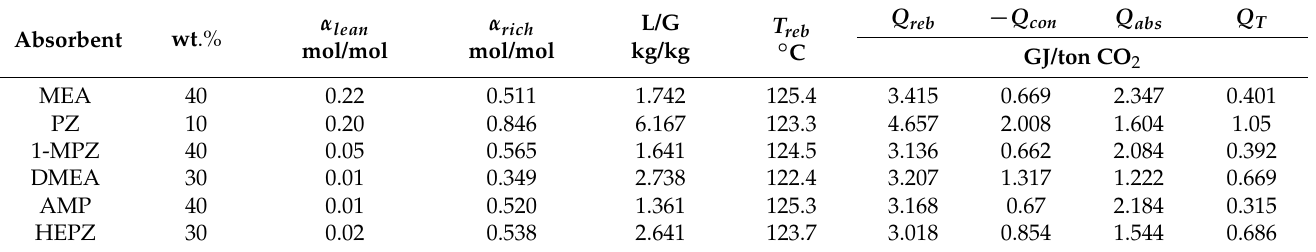
Table 2. The lowest reboiler energy and process parameters of different solvents.